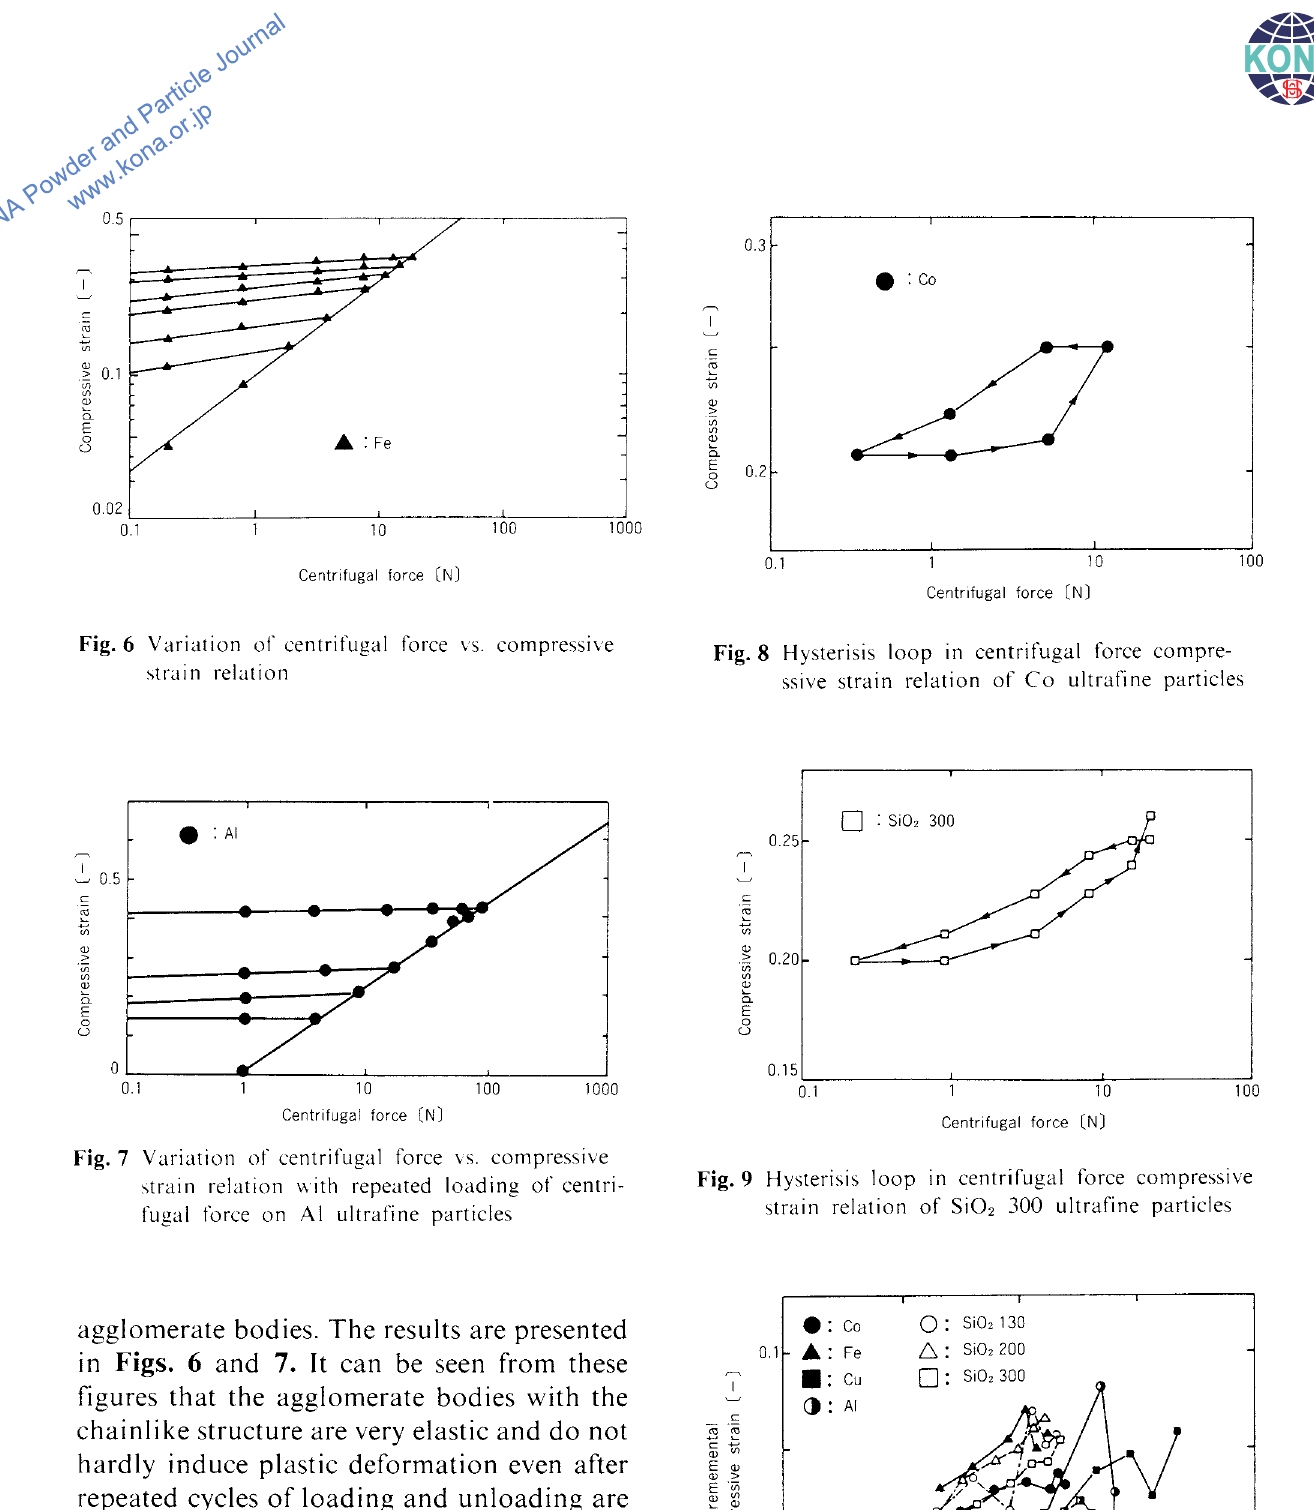
Fig. 10 Relationships between centrifugal force and incremental compressive